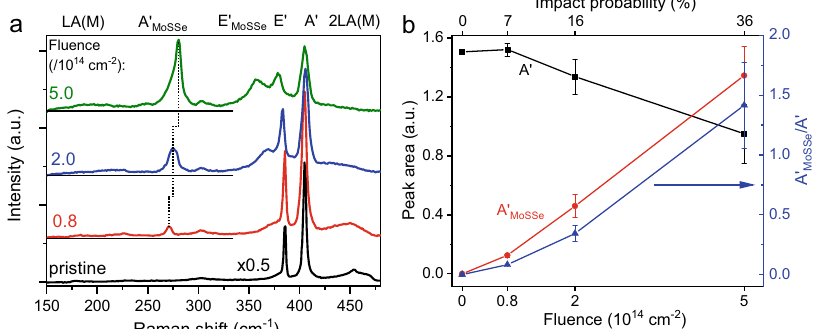
Fig. 5 Raman spectroscopy studies of MoS 2 MLs implanted with Se ions at 20 eV with different fl uences. a Room temperature Raman spectra of MoS 2 MLs implanted at four different fl uences. The spectra are normalized to the Si signal at 520 cm − 1 (not shown) and offset vertically for clarity. b Change of intensities of A ′ Raman lines with ion beam fl uence. Peak areas are obtained by fi tting with Voigt pro fi les with Origin (OriginLab). Error bars are associated standard error from the fi tting routine. The blue curve with the axis on the right shows the ratio , to that of the pristine S – Mo – S bonds, A ′ . between the out of-plane-vibration of S – Mo – Se bonds, A 0 MoSSe